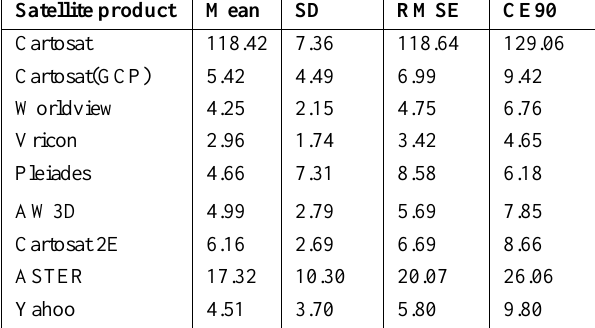
Table-2: Mean , Standard deviation (SD), Root mean square error (RMSE) and CE90 of Resultant circular shift for all data products